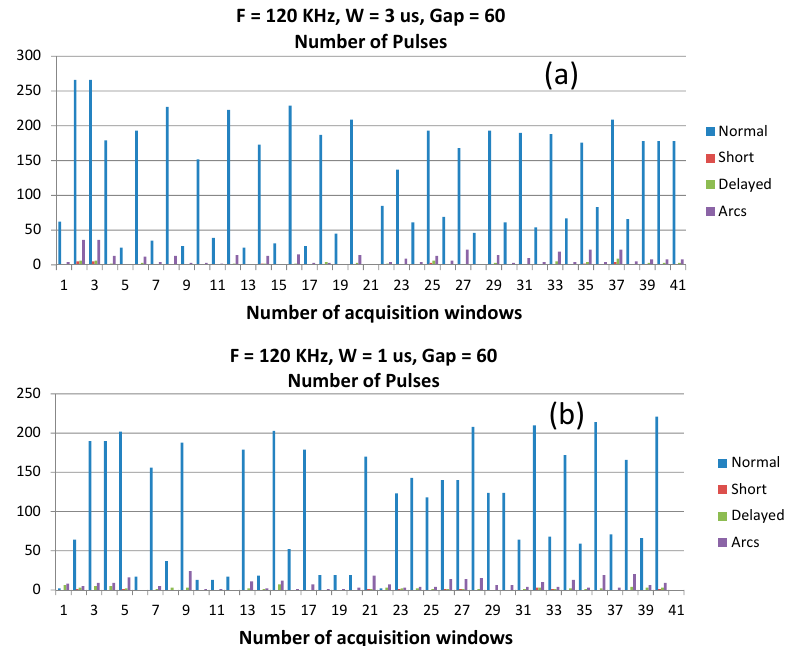
Figure 4. Number of normal pulses counted in the latest 40 acquisition windows for two different trials: ( a ) F = 120 kHz, W = 3 μ s, G = 60; ( b ) F = 120 kHz, W = 1 μ s, G = 60.